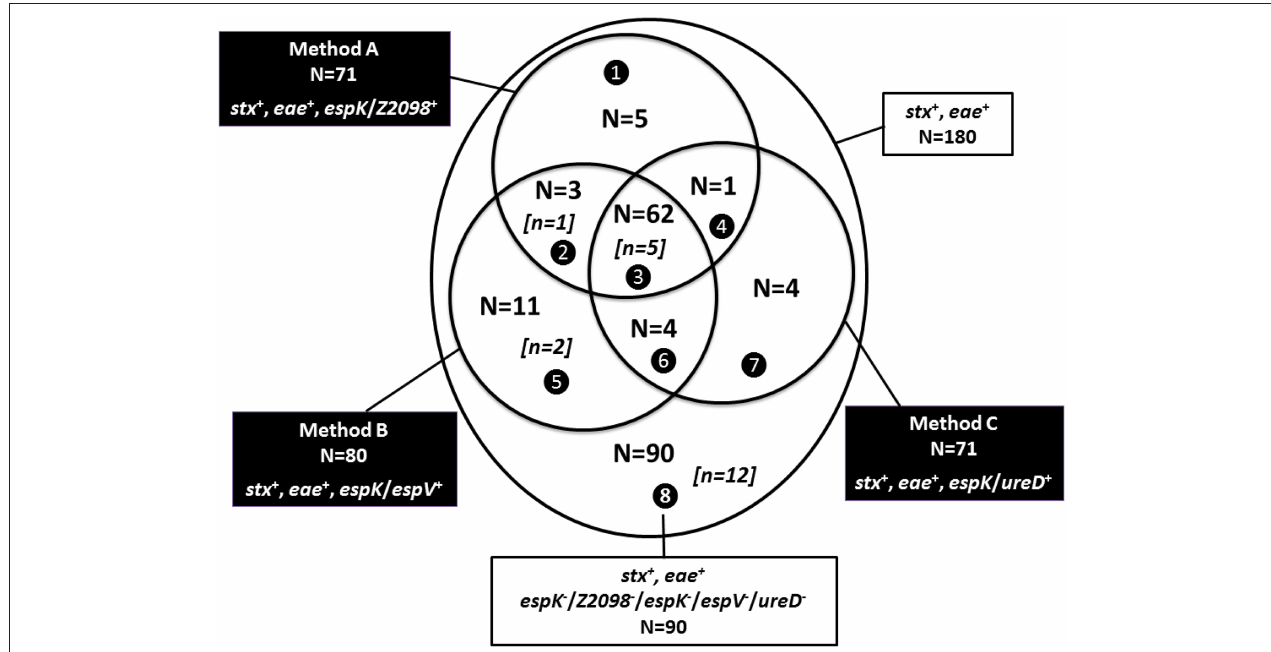
FIGURE 2 | Comparison of Methods A–C on 180 beef samples that tested positive for both stx and eae genes. stx + for samples giving a positive result for stx1 and/or stx2 ; eae + for samples giving a positive result for eae ; espK / Z2098 + for samples giving a positive result for espK and/or Z2098 ; espK / espV + for samples giving a positive result for espK and/or espV ; espK / ureD + for samples giving a positive result for espK and/or ureD . Sector ¶ ( stx + , eae + , Z2098 + ), sector · ( stx + , eae + , Z2098 + , espV + ), sector ¸ ( stx + , eae + , espK / Z2098 + , espK / espV + , espK / ureD + ), sector ¹ ( stx + , eae + , Z2098 + , ureD + ), sector º ( stx + , eae + , espV + ), sector » ( stx + , eae + , espV + , ureD + ), sector ¼ ( stx + , eae + , ureD + ) and sector ½ ( stx + , eae + ). [n = x] is the number of samples that tested positive by the CRISPR O26 : H11 PCR assay detecting the new O26 clone, N = x is the total number of samples per